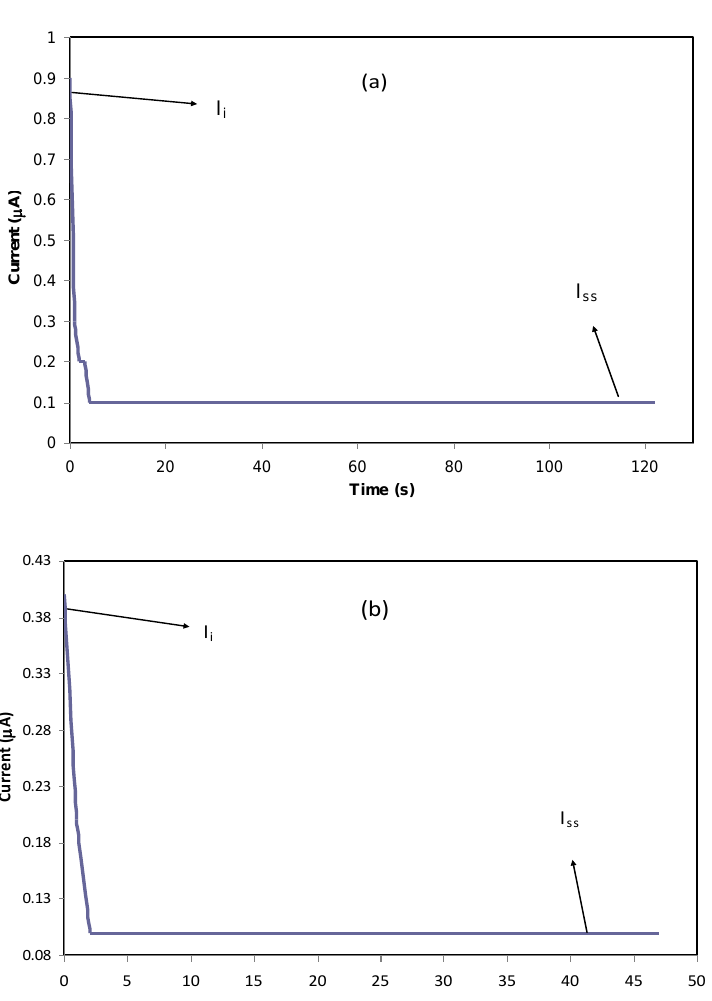
Figure 14. TNM measurement setup. 3.5.2. Linear Sweep Voltammetry (LSV) Studies In order to determine the electrochemical stability of the polymer electrolyte under study, linear sweep voltammetry (LSV) is a straightforward and powerful technique to use. LSV was performed